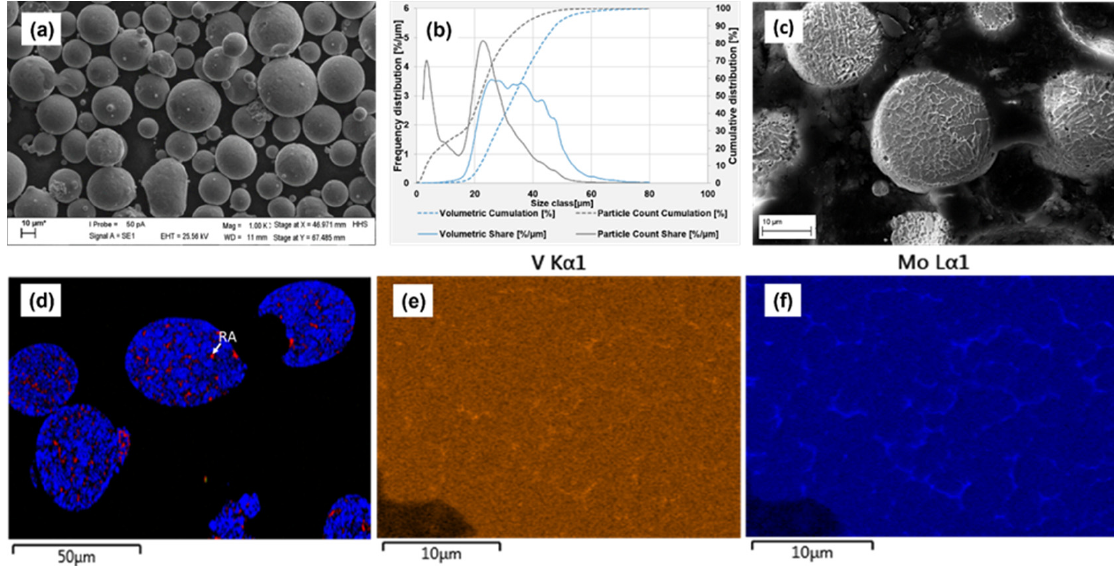
Figure 1. ( a ) The SEM-morphology of the standard 1.2343 steel powder particles. ( b ) Particle size distribution (PSD). ( c ) Particle cross-section with cellular microstructure. ( d ) EBSD image of the martensite and retained austenite (RA). ( e , f ) EDS images showing the V- and Mo-micro segregations on the cell boundaries.